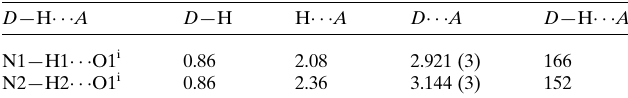
Table 1 Hydrogen-bond geometry (A˚ , (cid:2) ).